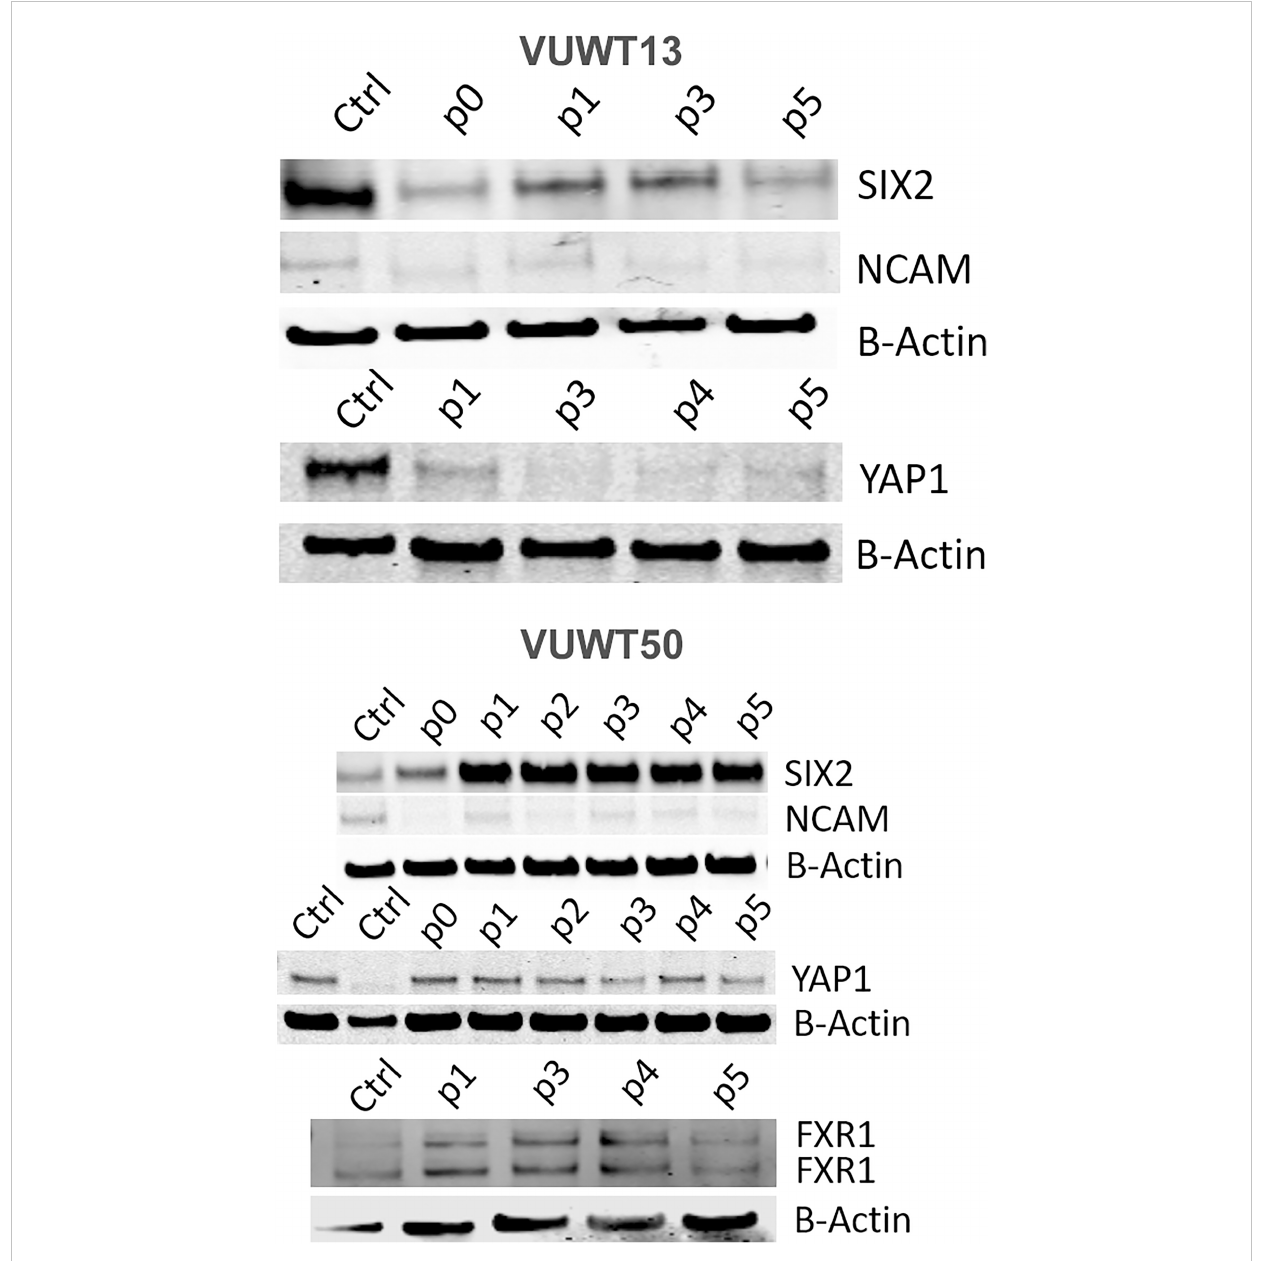
FIGURE 5 Immunoblot analyses of VUWT13 and VUWT50 for the expressions of common Wilms tumor markers, SIX2, YAP1, NCAM, and FXR1. All markers were demonstrable through multiple culture passages with some variation.